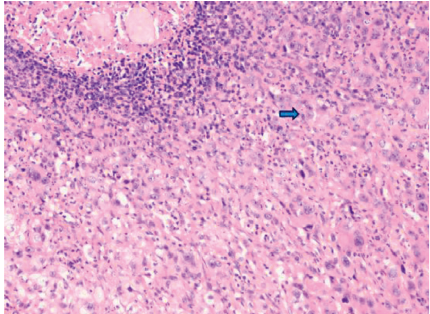
Figure 2: Hematoxylin and eosin staining, × 200. Microscopically, the tumor comprised epithelial cells (Arrow), with an eosinophilic cytoplasm and an abnormal core.